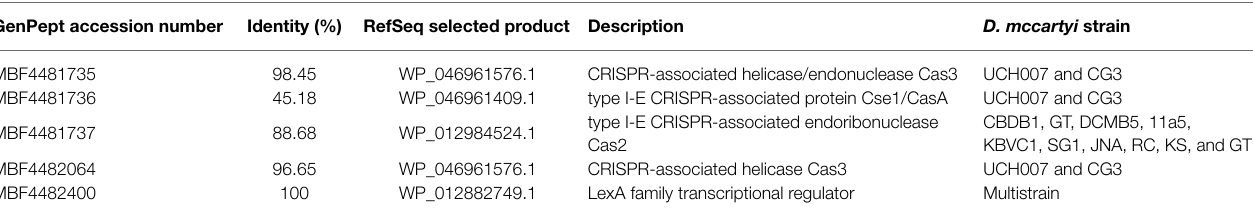
TABLE 3 | Genes linked to the CRISPR-system found in D. mccartyi from the TCE/Cr(VI) biocathode. GenPept accession number Identity (%) RefSeq selected product